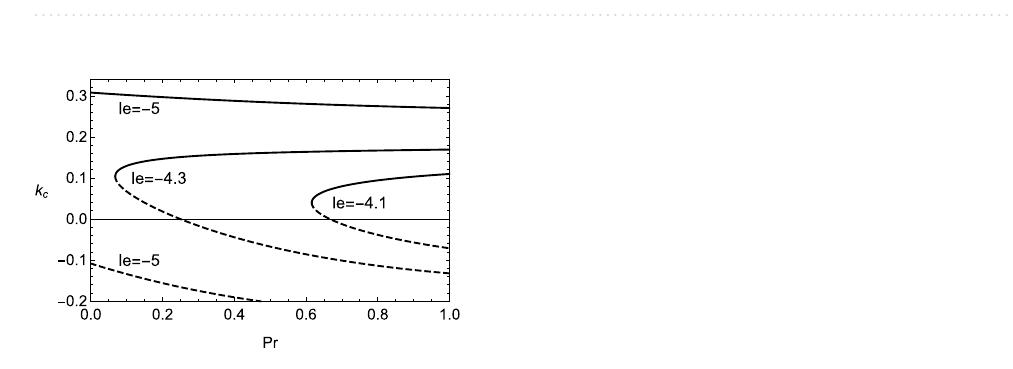
Figure 8. Stability boundary with respect to Lewis number and Prandtl number for small wavenumber with 10 . The values of le less than each curve implies the existence of cellular instability for each value of q . β =